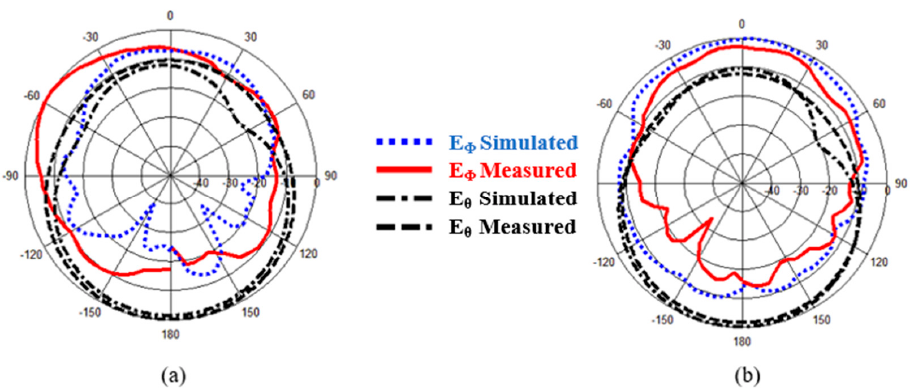
Figure 7. Simulated and measured radiation patterns for the proposed filtering antenna ( a ) xz plane, and ( b ) yz plane.